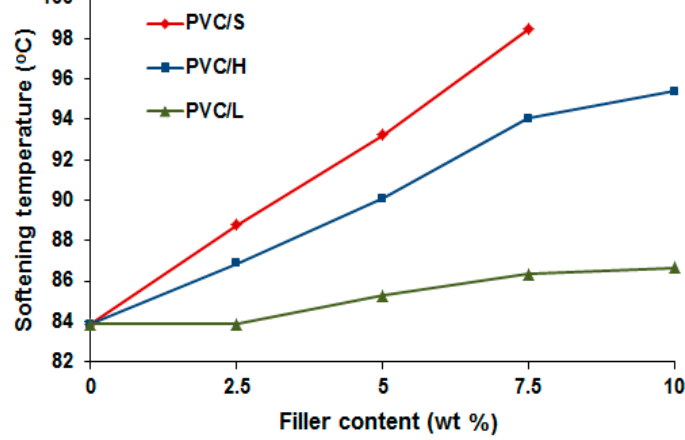
Figure 8. Softening temperature of PVC and PVC-based composites vs. filler content (PVC/S, PVC/L and PVC/H).